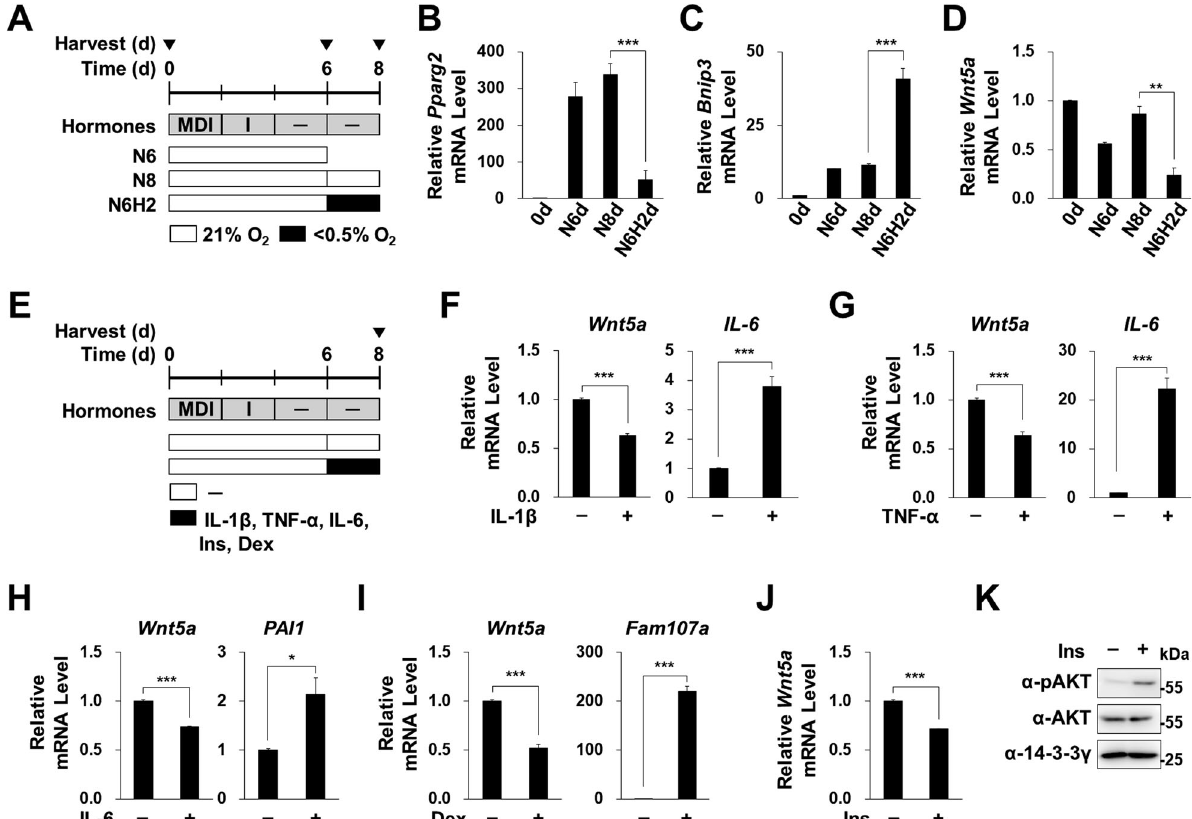
Fig. 2 Effects of hypoxia and in fl ammatory cytokines on Wnt5a expression. A Postcon fl uent 3T3-L1 preadipocytes were induced to undergo adipogenesis by treating them with adipogenic hormones (IBMX (M), dexamethasone ( D ), and insulin ( I )) as previously described